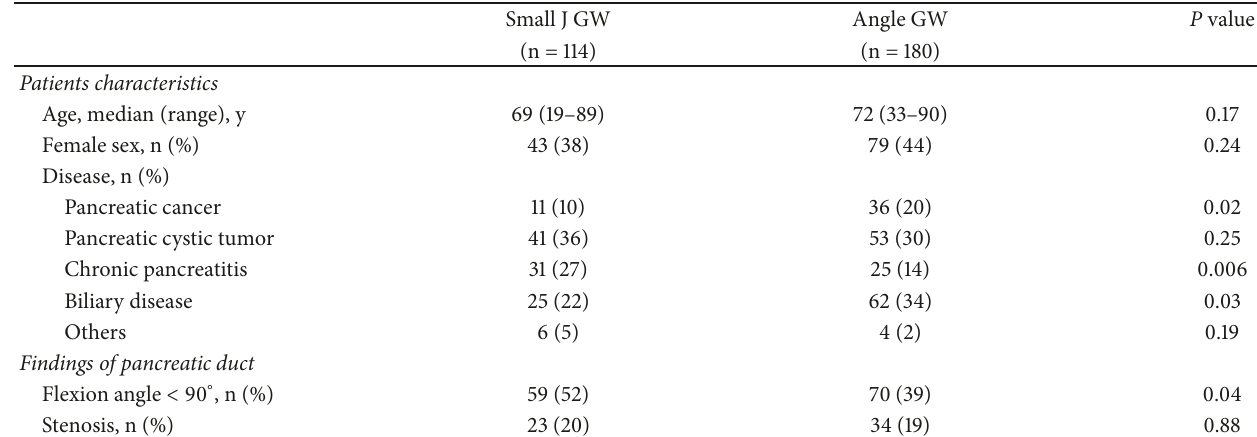
Table 1: Characteristics.